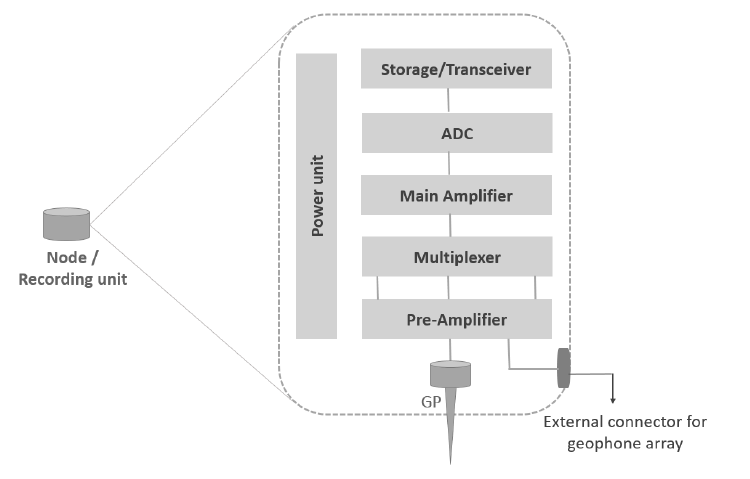
Figure 2. The components of a node or recording unit